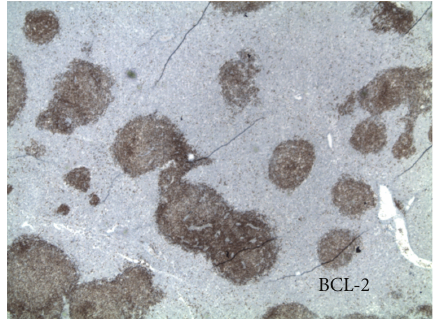
Figure 3: Histopathology of splenic tissue. Note the presence of small cleaved cells (centrocytes) suggestive of mantle cell non- Hodgkin’s lymphoma.